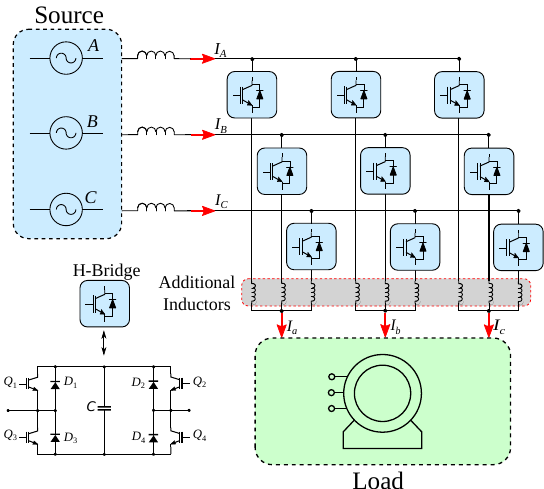
Figure 14. M3C topology with inductors added to the modules.